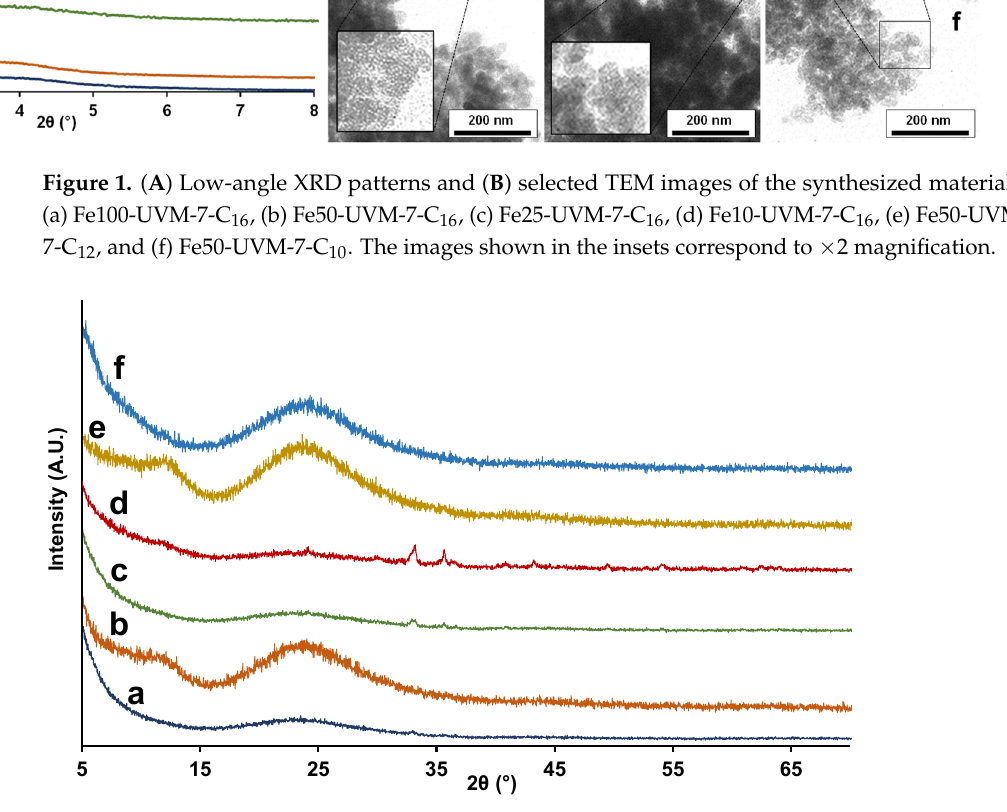
Figure 2. High-angle XRD patterns of the synthesized materials: (a) Fe100-UVM-7-C 16 , (b) Fe50-UVM-7-C 16 , (c) Fe25-UVM-7-C 16 , (d) Fe10-UVM-7-C 16 , (e) Fe50-UVM-7-C 12 , and (f) Fe50-UVM-7-C 10 .